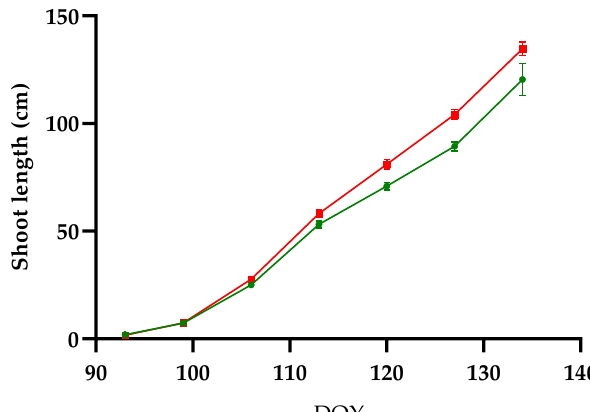
Figure 5. Growth of primary shoot in the covered vineyards C (green line) and S (red line) (bars represent standard errors of measurements). After the third week of April, the shoot growth rate in vineyard S began to increase modestly but significantly faster, indicating a slight trend towards a greater vigor and expansion of the vine canopy.